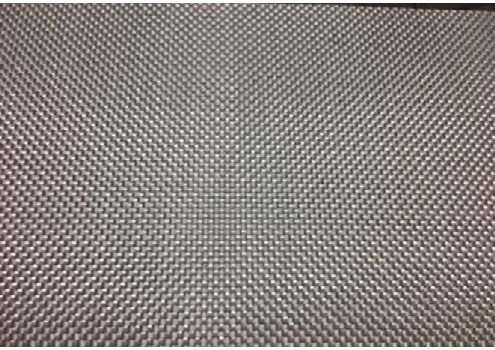
Figure 5. Glass fiber sheet .